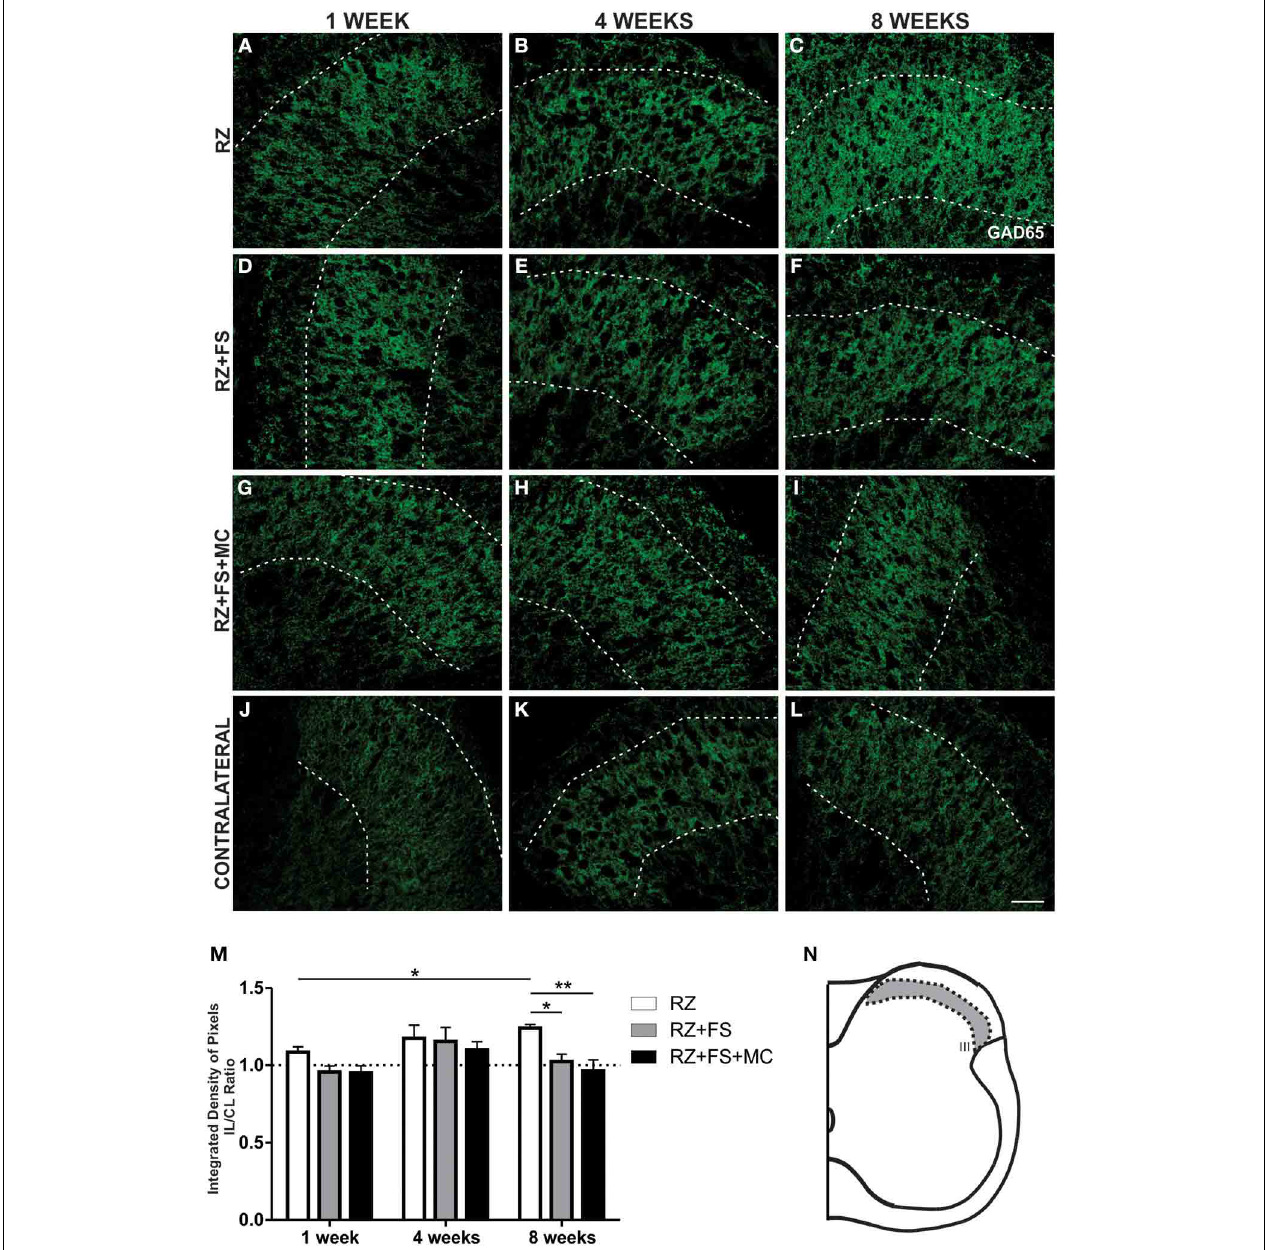
FIGURE 12 | Immunohistochemistry for GAD65. (A–L) Representative images of RZ, RZ + FS and RZ + FS + MC, 1, 4, and 8 weeks post lesion. (M) Quantification (ratio IL/CL) of the integrated density of pixels, obtained in the region delimited by dashed